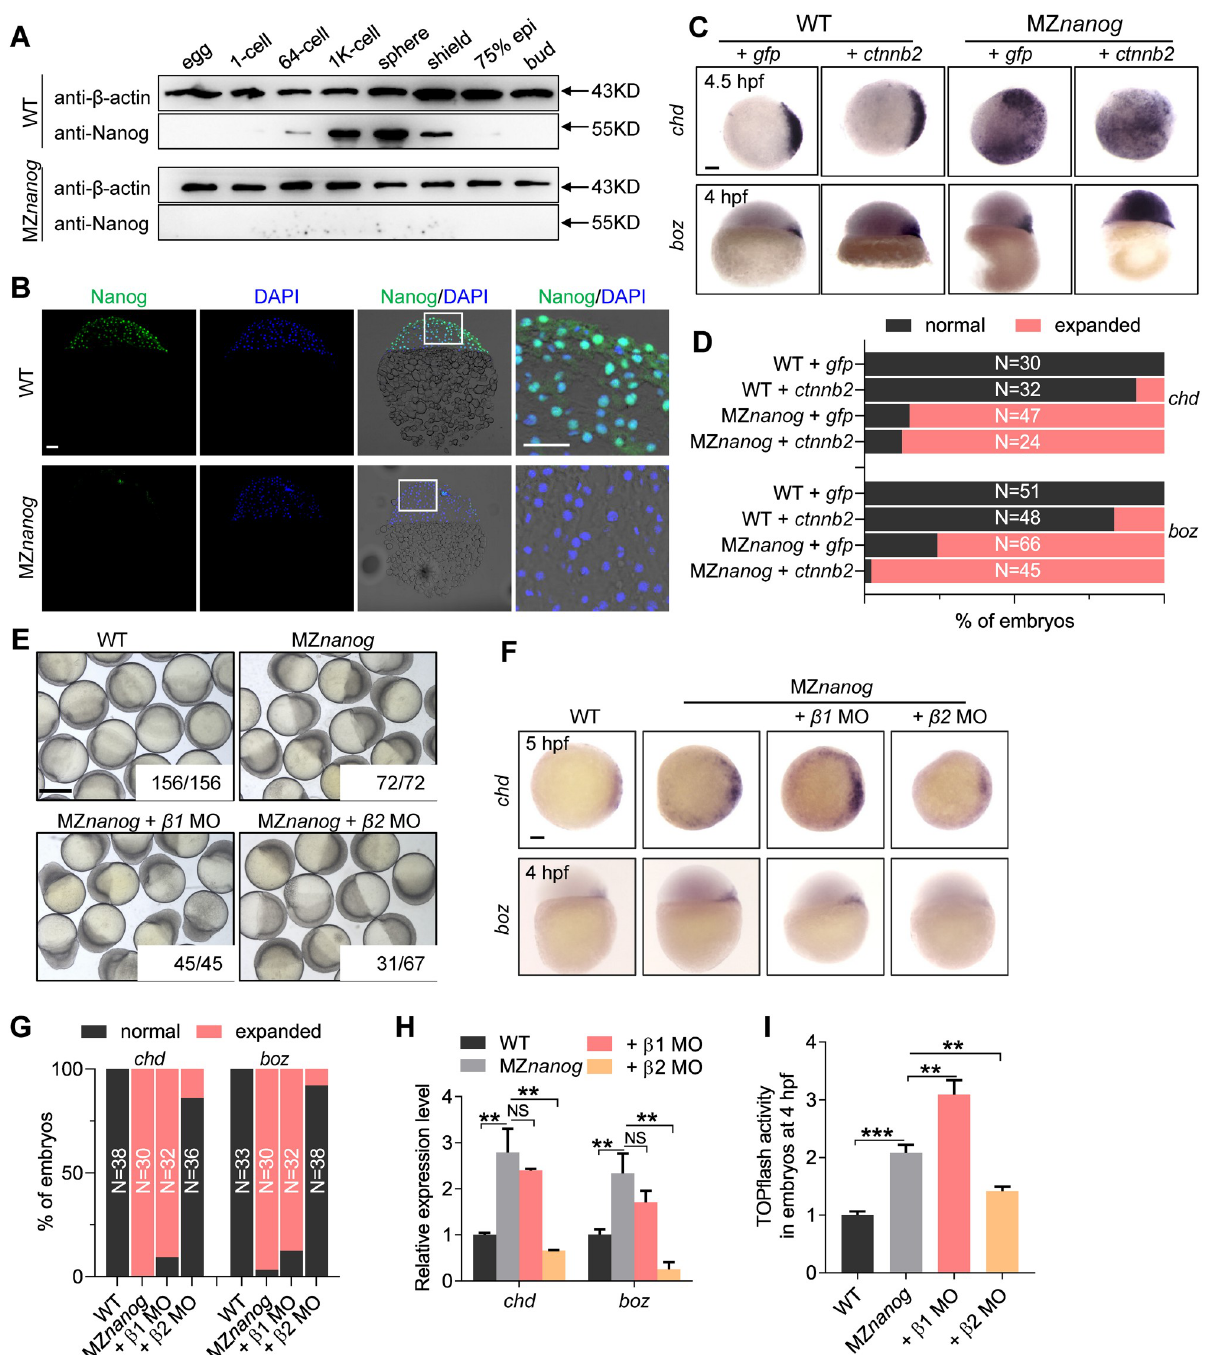
Fig 4. Maternal β -catenin activity is hyperactivated in nanog mutant. (A) western blot showing translation of Nanog protein totally disappeared in MZ nanog . Nanog protein can be detected as early as the 64-cell stage and vanished at 75% epiboly stage in WT embryos, whereas no Nanog protein was detected in MZ nanog mutant embryos. (B) Immunolocalization of Nanog on cryosections of WT and MZ nanog embryos at 4 hpf. Nanog is localized in the cell nuclei of WT embryos and disappeared in MZ nanog embryos. Nuclei were co-stained with DAPI. Scale bar, 50 μ m. (C) WISH analysis showing the injection of low dose of ctnnb2 mRNA (200 pg) induced slight up-regulation of boz and chd in WT embryos and induced massive expression of boz and chd in MZ nanog embryos. boz was detected at 4 hpf, and chd was detected at 4.5 hpf. Scale bar, 100 μ m. (D) Statistical analysis of the embryos in panel C. N represents analyzed embryo number. (E) Knockdown of ctnnb2 but not ctnnb1 rescued the developmental defects of MZ nanog at gastrula stage. The numbers below the morphology pictures are the number of embryos showing representative phenotype/total number of embryos. Scale bar, 500 μ m. (F) WISH analysis showing expression of chd and boz were expanded in MZ nanog embryos, and knockdown of ctnnb2